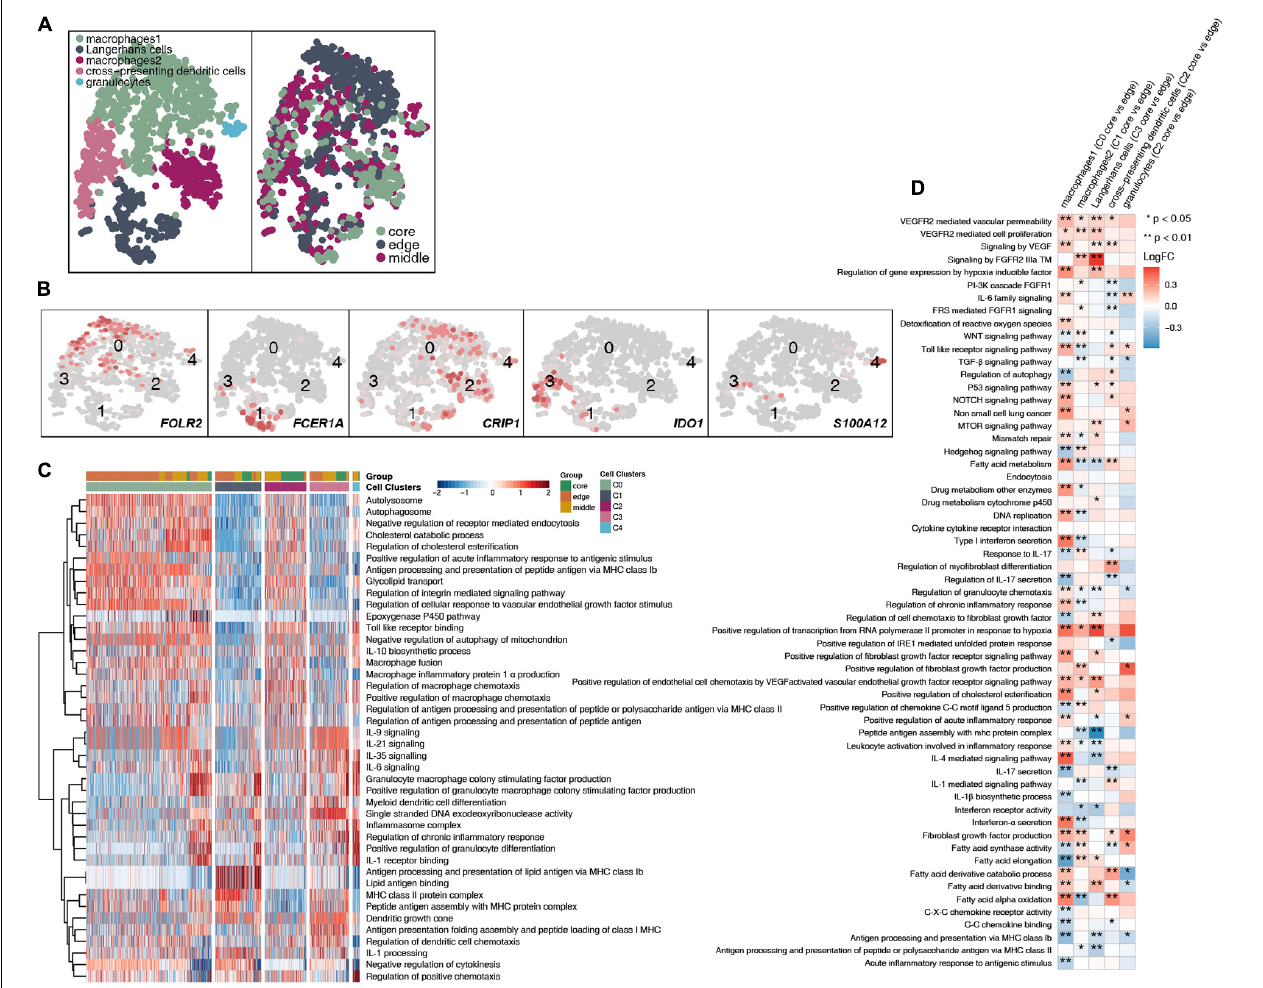
FIGURE 6 | Myeloid cell clusters in LUAD. (A) tSNE plot of 1,524 myeloid cells, which are color-coded by their associated cluster or the sample location. (B) tSNE plot, which is color-coded for expression of marker genes for the cell types, as indicated. (C) Heatmap of the ssGSEA score, as estimated using gene sets from MsiDB, for five myeloid cell clusters from macrophages (cluster 0), Langerhans cells (cluster 1), macrophages (cluster 2), cross-presenting dendritic cells (cluster 3) and granulocytes (cluster 4). (D) Heatmap depicting the mean differences in pathway activities scored per cell by GSVA between the tumor core and tumor edge across the macrophages (cluster 0), Langerhans cells (cluster 1), macrophages (cluster 2), cross-presenting dendritic cells (cluster 3) and granulocytes (cluster 4). The x -axis of the heatmap indicates different myeloid cell clusters, and the y -axis indicates pathway activities scored per cell by GSVA. Each square represents the fold change or difference in each indicated pathway activity scored per cell by GSVA between the tumor core and tumor edge across macrophages (cluster 0), Langerhans cells (cluster 1), macrophages (cluster 2), cross-presenting dendritic cells (cluster 3) and granulocytes (cluster 4). Red indicates upregulation, while blue indicates downregulation. * P < 0.05; ** P <